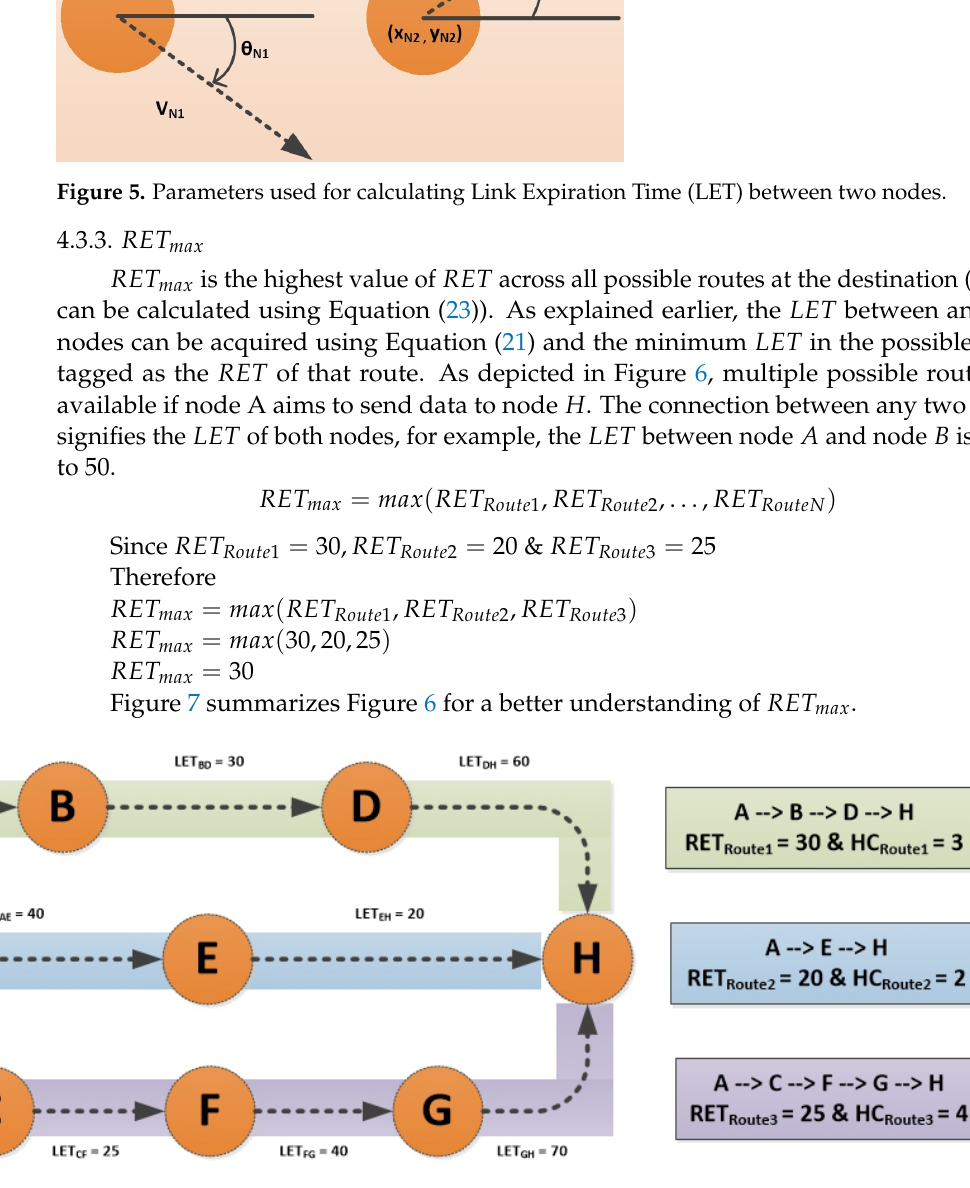
Figure 6. Route Expiration Time (RET) and Hop Count (HC) for all possible